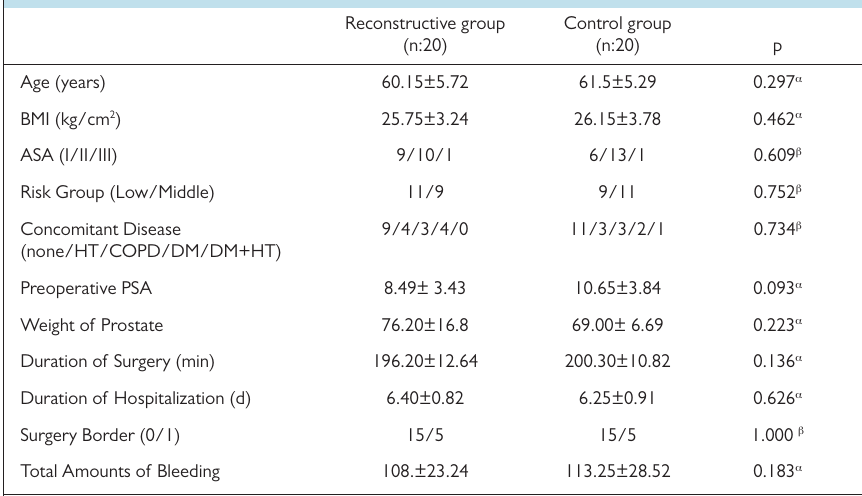
Figure 1. Long urethral stump. Figure 2. Anterior suspension suture. Table 1. Demographic data and comparison of preoperative and postoperative